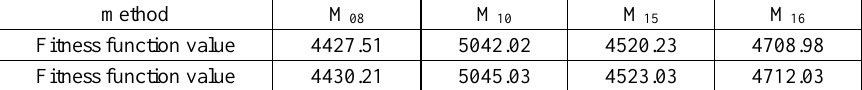
Table 9. Calculated results of different ship